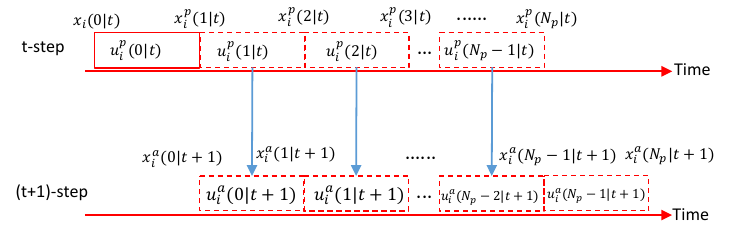
Figure 2. Basic procedure to construct assumed torque inputs and assumed kinetic